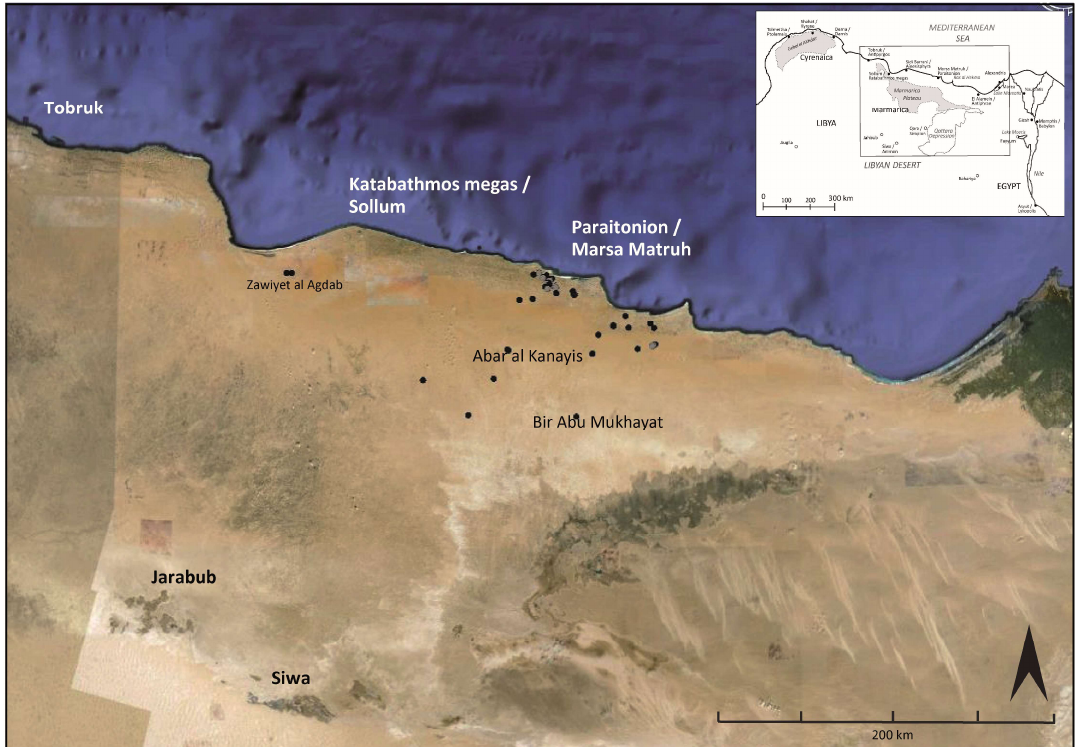
Figure 3. Satellite image of the eastern parts of the arid landscape of the Marmarica showing geographical units and settlements referred to in the text. Created with Google Earth V 7.3.2.5495 (Google, Mountain View, CA, USA). Image: Landsat/Copernicus 2016, as base map.